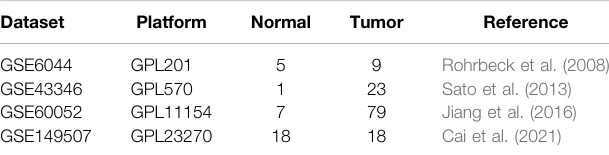
TABLE 1 | Basic characteristics of four GSE